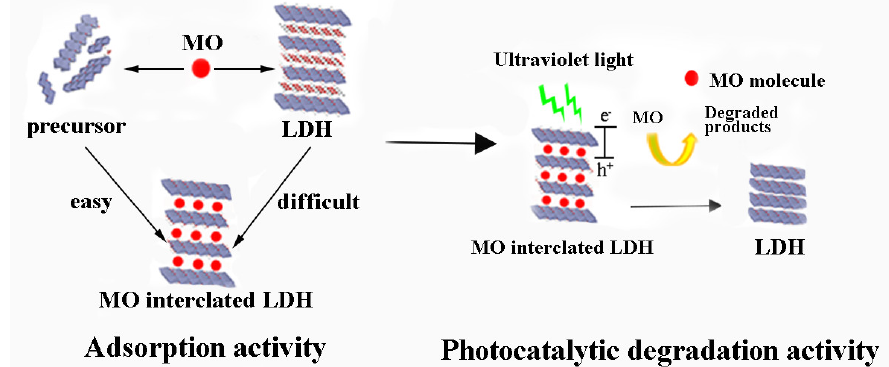
Figure 9. Precursor of Zn-Al LDH for enhanced adsorption and photocatalytic decoloration of MO